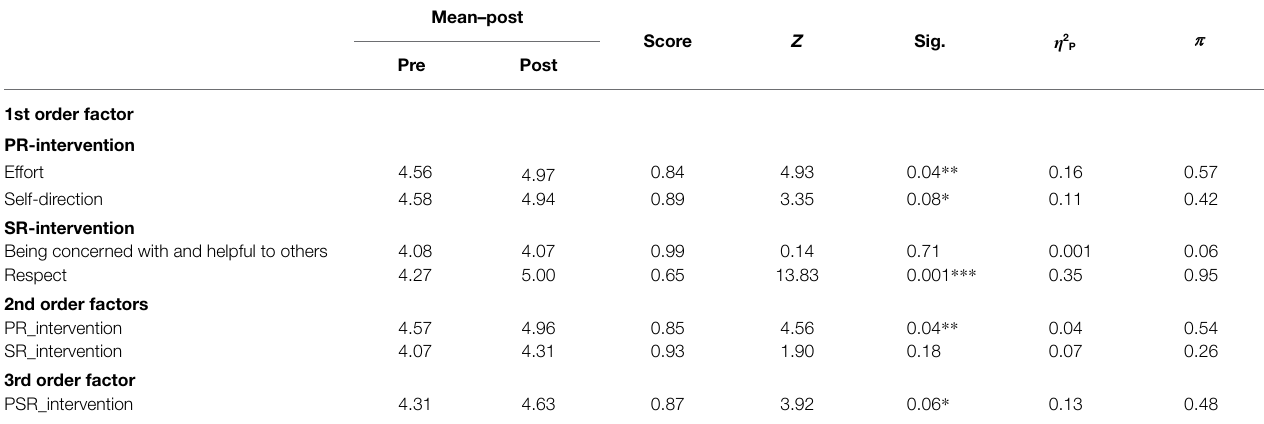
TABLE 6 | Multiple factor comparison tests (Lambda of Wilks), power and effect of the variables in the intervention group. Mean–post